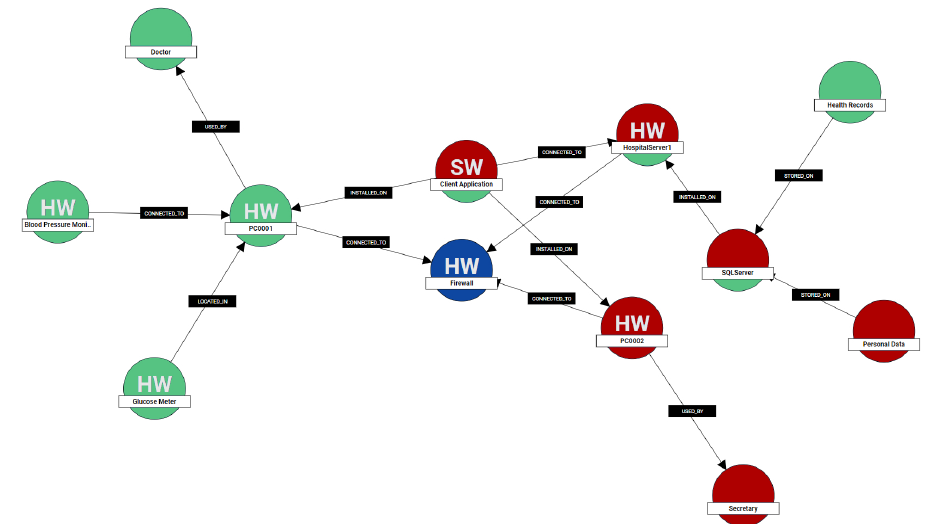
Figure 4. Asset interdependency graph with the processing activities